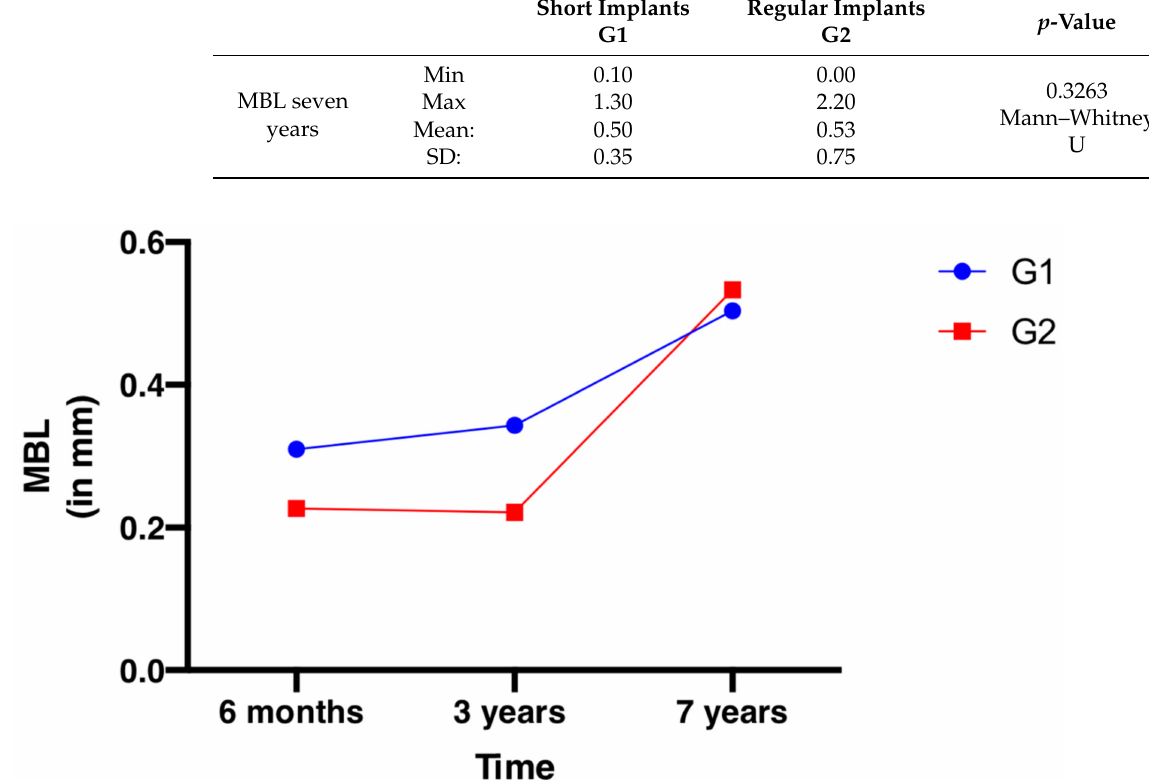
Figure 7. Change of marginal bone loss (MBL) over time. Six months, 36 months, seven years. For G1 and